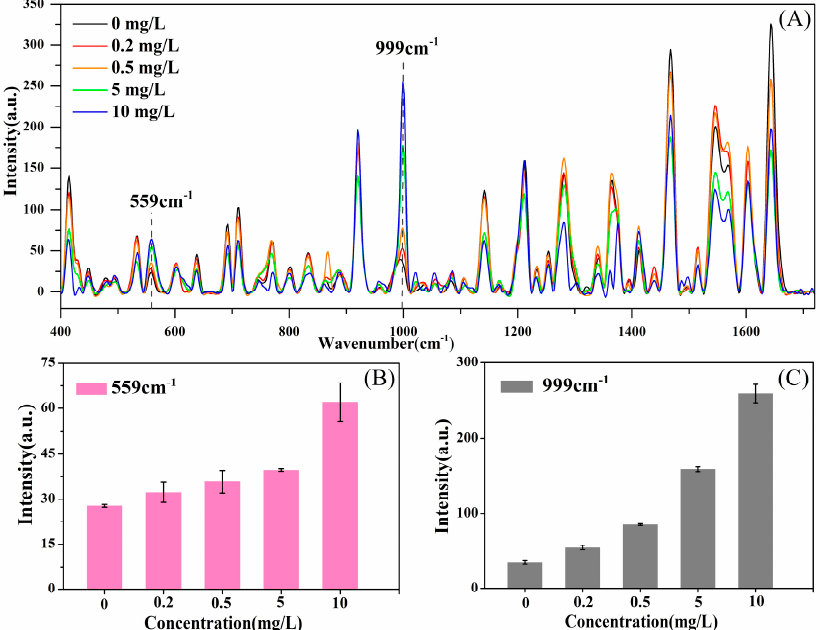
Molecules 2020 , 25 , x 10 of 16 Figure 6. Raman spectra of different levels of deltamethrin added to Corydalis . ( A ) SERS of Figure 6. Raman spectra of di ff erent levels of deltamethrin added to Corydalis . ( A ) SERS of deltamethrin deltamethrin concentration adding in Corydalis sample from 0 to 10 mg/L; ( B ) peak intensity of 559 concentration adding in Corydalis sample from 0 to 10 mg / L; ( B ) peak intensity of 559 cm − 1 under cm − 1 under different levels of deltamethrin; ( C ) peak intensity of 999 cm − 1 under different levels of di ff erent levels of deltamethrin; ( C ) peak intensity of 999 cm − 1 under di ff erent levels of deltamethrin. deltamethrin.